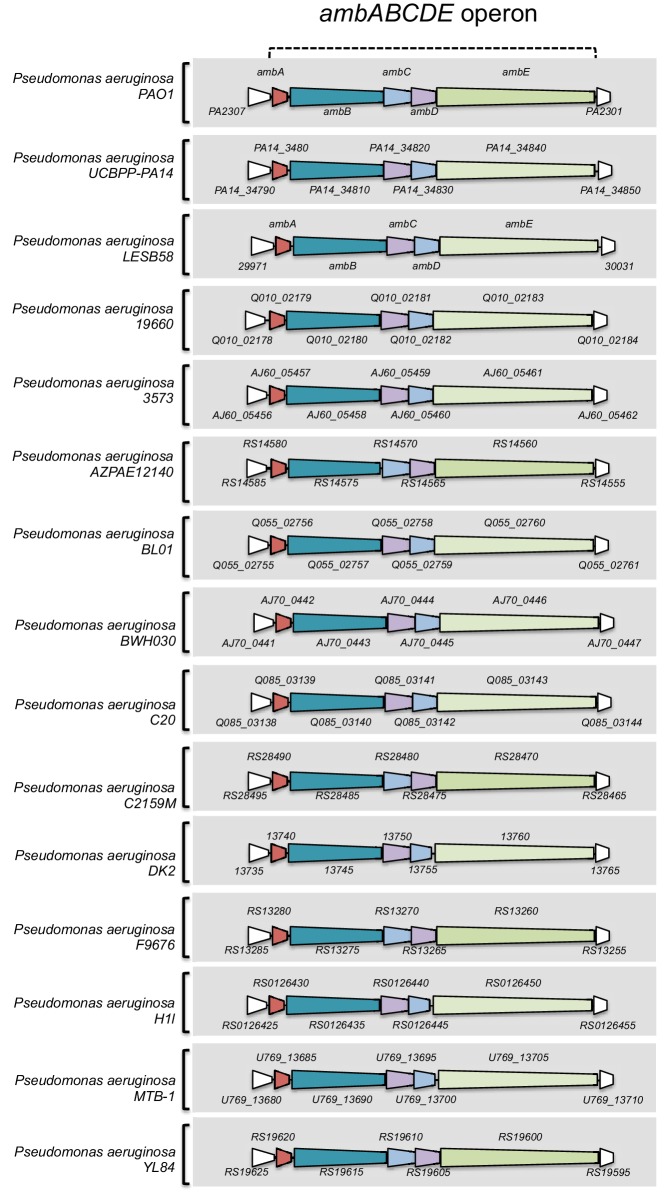
Presence of the ambABCDE operon in at least 15 other P. aeruginosa strains.Non-exhaustive list of 15 different P. aeruginosa strains containing ambABCDE genes in there genomes. Ortholog genes and structural operon organization where defined based on Pseudomonas database (http://www.pseudomonas.com/).10.7554/eLife.37082.027Figure 4—figure supplement 11—source data 1.Description of 15 different Pseudomonas aeruginosa strains containing the ambABCDE operon in their genomes.